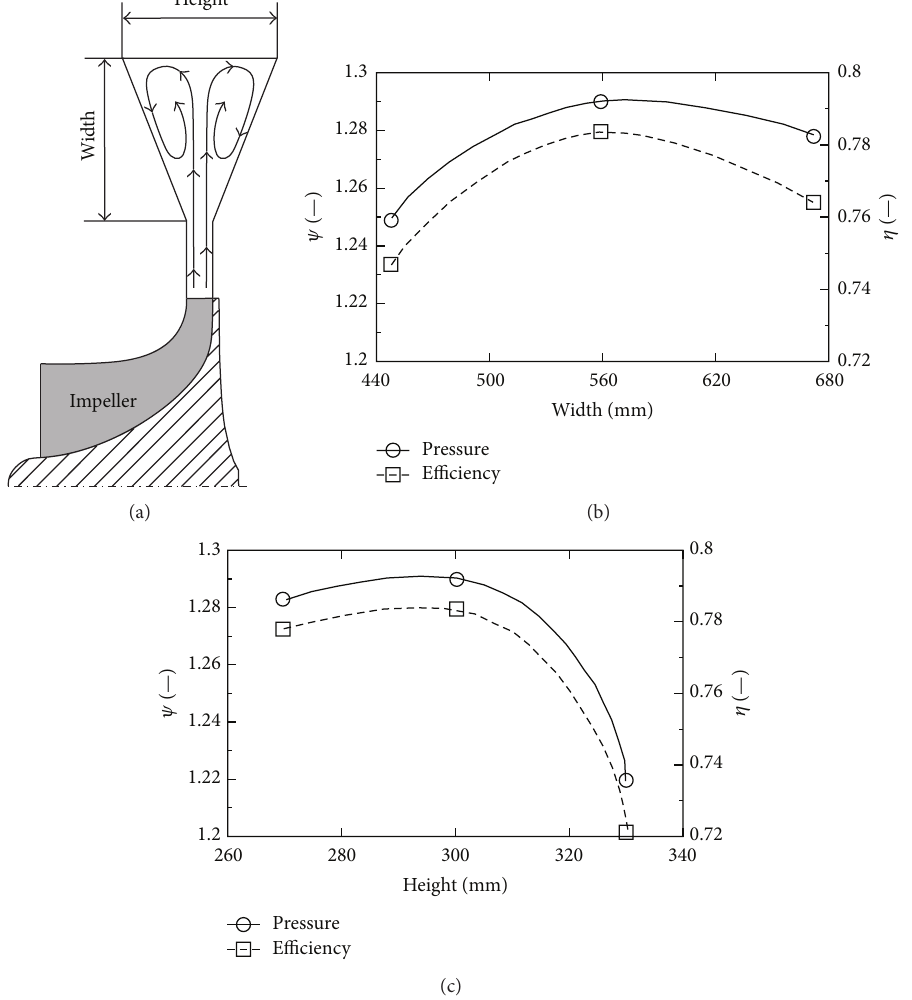
Figure 2: Volute cross-sectional shape and geometric parameters (a) and blower performance for varying width at reference height of 300 mm (b) and varying height at reference width of 560 mm (c) according to Jang et al. [13].